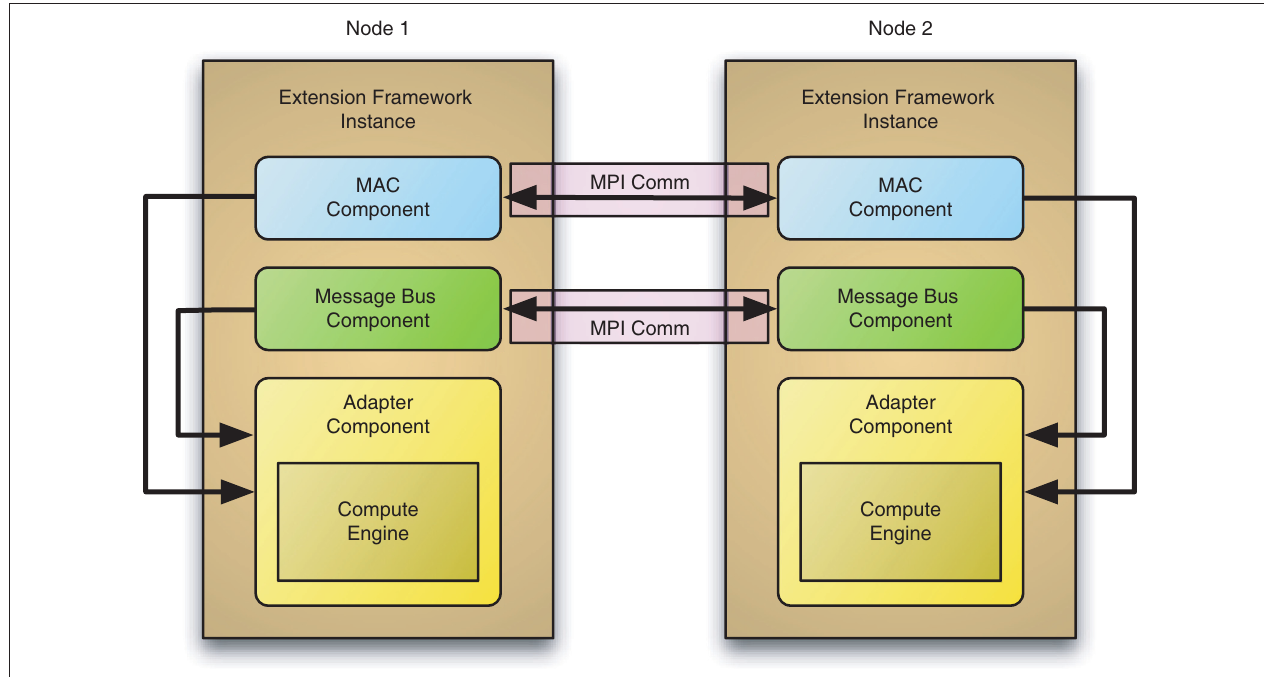
FIGURE 1 | The structural organization of component-based Extension Framework. An instance of it running on a node consists of different components. One component allows access to a Compute Engine, providing a common interface to other components. A Message Bus Component implements network connectivity, handling the exchange of APs among nodes. A MAC (monitor, analyze, control) Component may perform simulation analysis or modify simulation